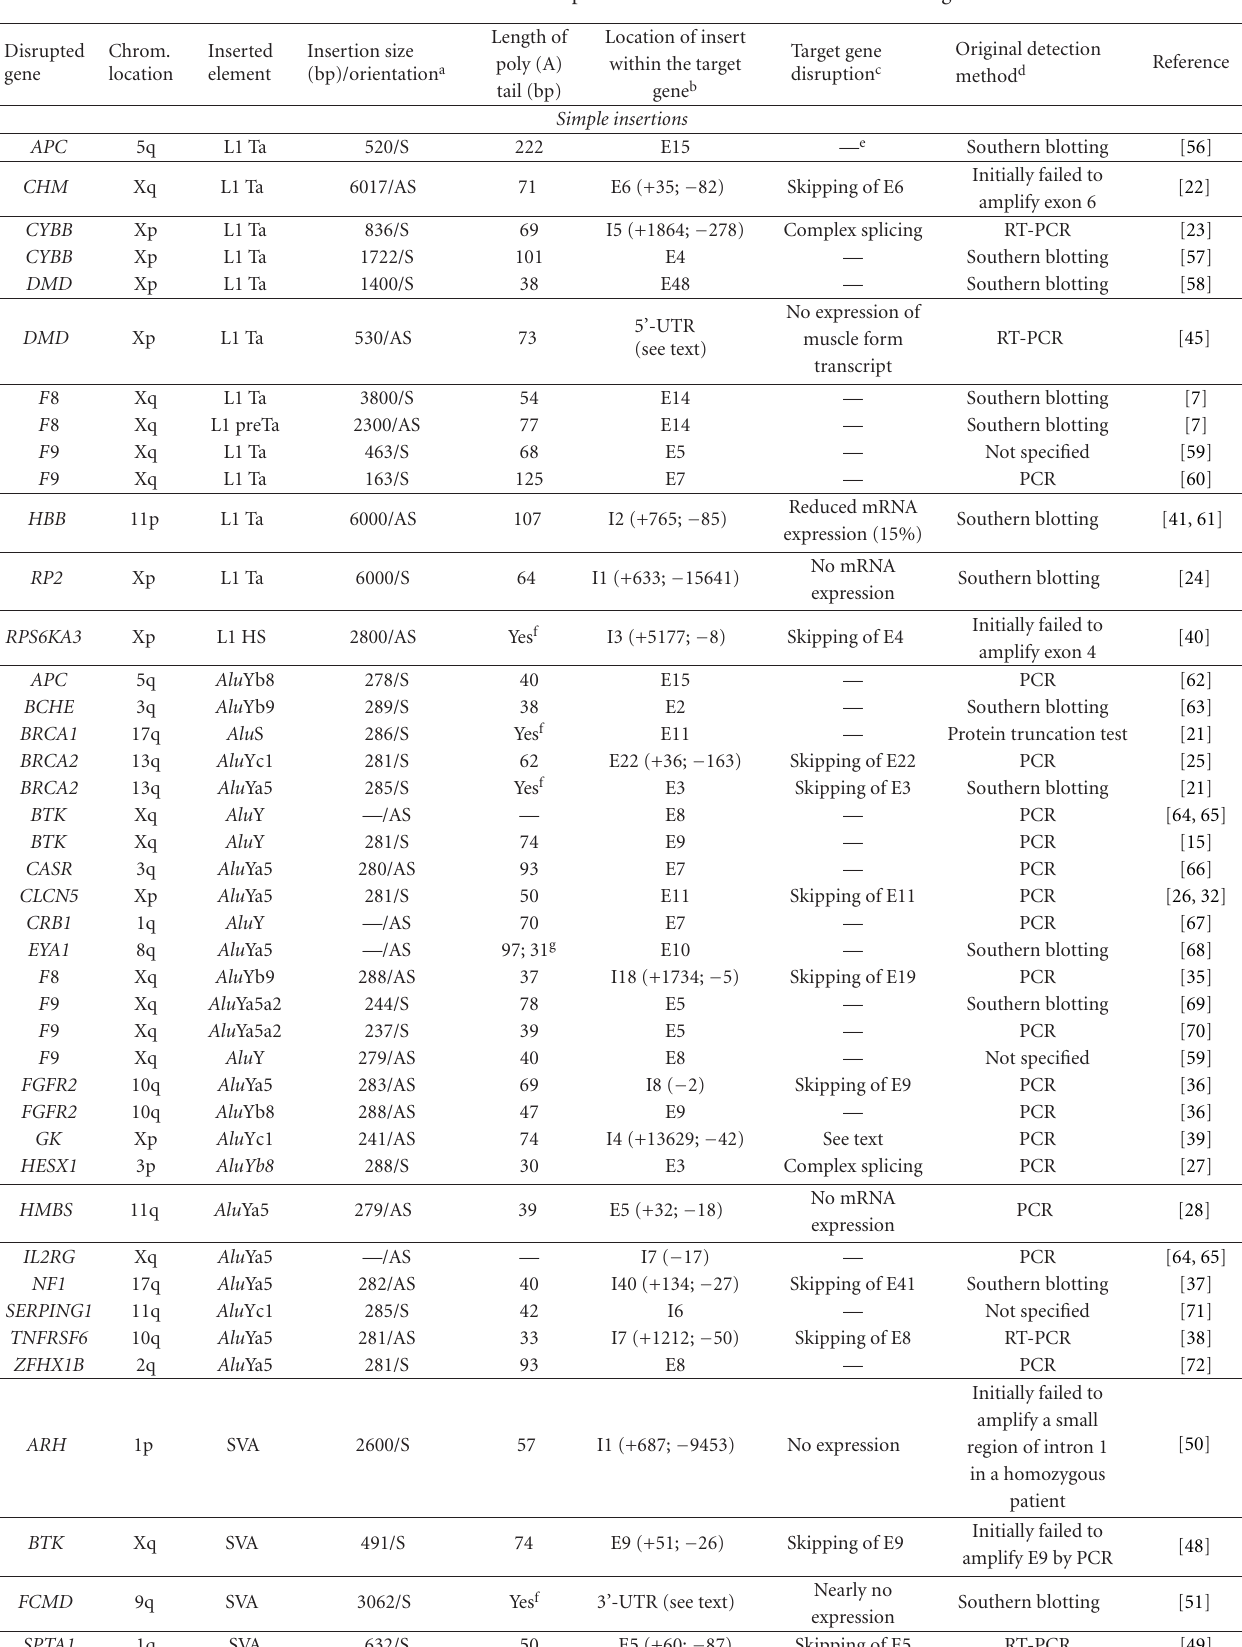
Table 1: L1 endonuclease-mediated retrotranspositional events known to cause human genetic disease. ∗